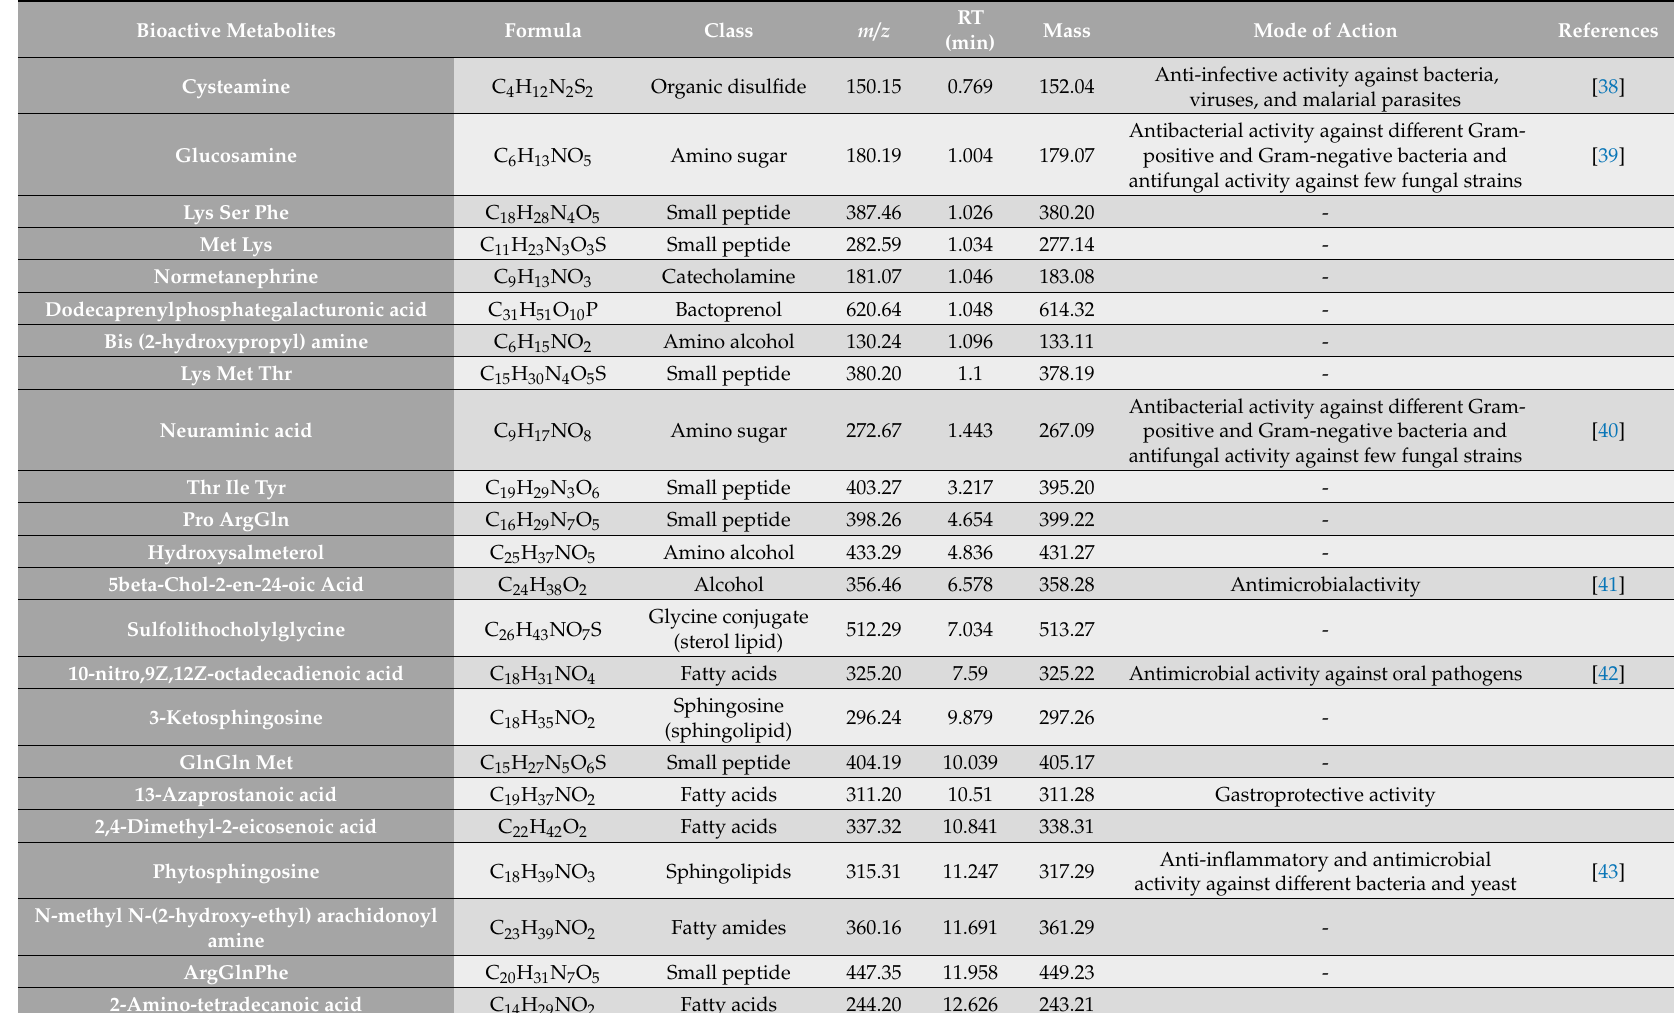
Table 3. Identified major bioactive metabolites by HR-LCMS from P. sophore mucus extract with their